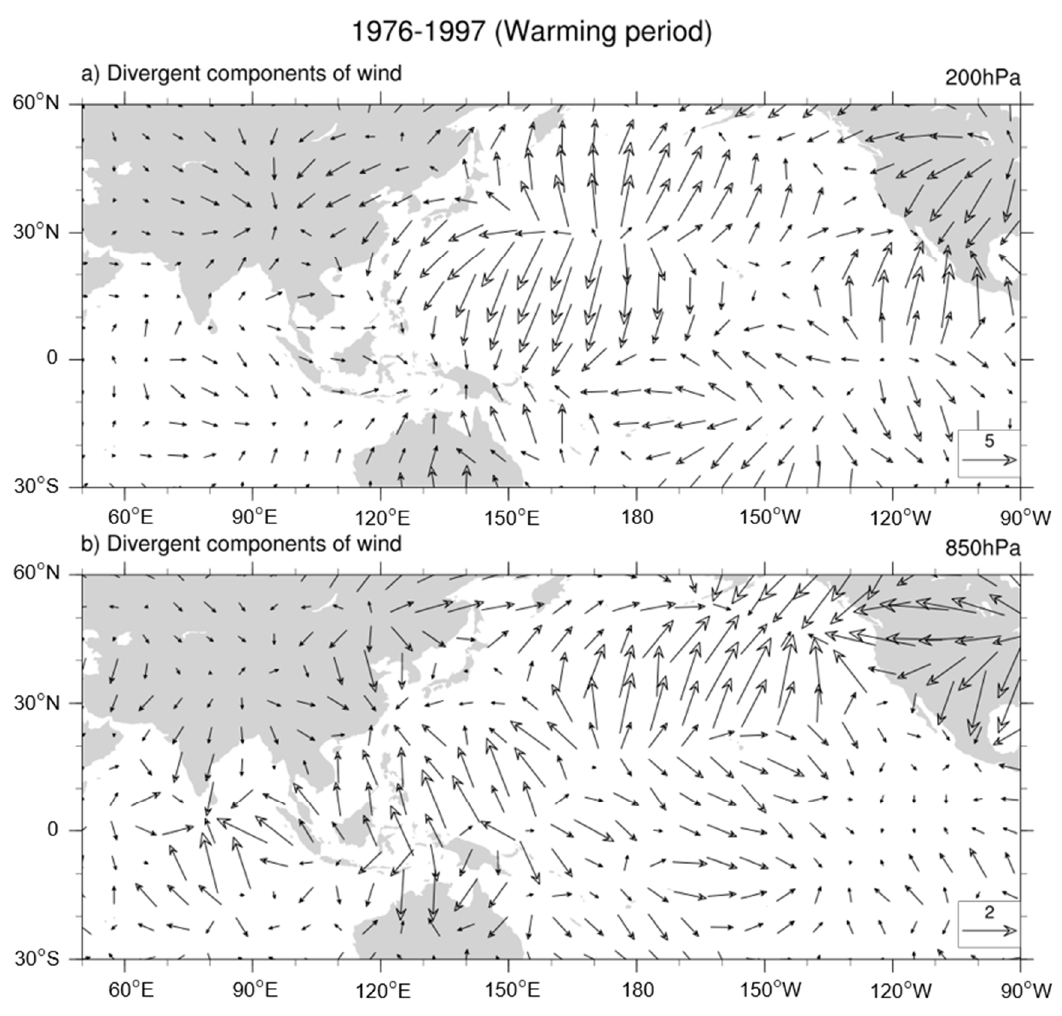
Figure 15. Divergent components of the composite anomalies between positive and negative years of EOF2 in wind at 200 hPa ( a ) and 850 hPa ( b ) during the warming period. The di ff erence in SSTs during the hiatus period and warming period is shown in Figure 17. SSTs are cooler in the east-central tropical Pacific, which shows a La Niña-like pattern. As warmer SSTs in the east-central tropical Pacific are beneficial for maintaining the dipole mode of water vapor transport, the background of cooler SSTs in the hiatus period is unfavorable for this structure. Therefore, there tends to be a weaker water vapor supply and less rainfall over the YZ during the hiatus